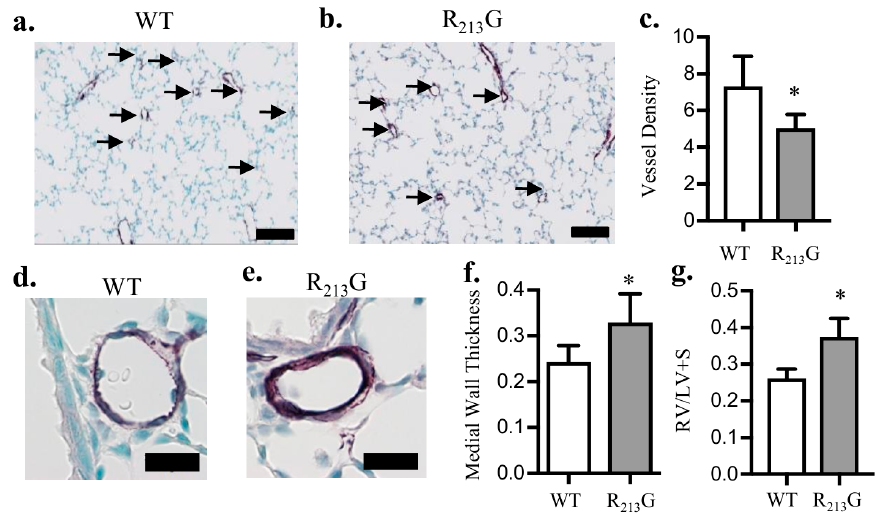
Figure 2. Mice expressing the R 213 G SNP had impaired pulmonary vascular development and pulmonary hypertension at 22 days. ( a , b ) Representative images of von willebrand factor (vWF) (purple) staining in ( a ) WT and ( b ) R 213 G control mice. Arrows indicate vessels < 30 μ m, scale bar = 100 μ m. ( c ) Vessel density in WT and R 213 G mice, * p < 0.05 by unpaired t -test, n = 5–6. ( d , e ) Representative images of alpha smooth muscle actin ( α SMA) (purple) staining in ( d ) WT and ( e ) R 213 G mice, scale bar = 20 μ m. ( f ) Medial wall thickness in WT and R 213 G mice; * p < 0.05 vs. WT phosphate buffered saline (PBS) by unpaired t -test, n = 5–6. ( g ) Right ventricular (RV)/left ventricular (LV) + septal (S) (RV/LV + S) weights in WT and R 213 G control mice, * p < 0.05 vs. WT PBS by unpaired t -test, n = 5–6.